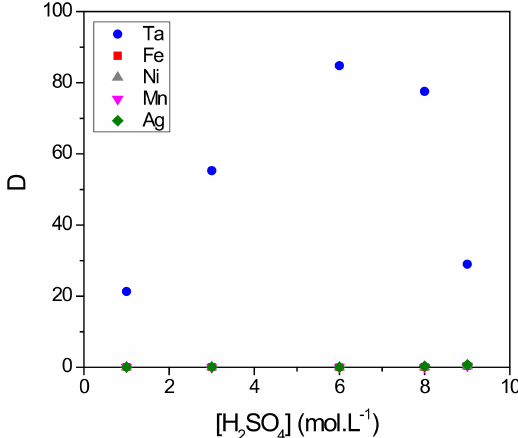
Figure 6. Effect of H 2 SO 4 concentration on the distribution coefficient D of Ta, Fe, Ni, Mn and Ag. Extraction conditions: A/O = 1; T = 22 ◦ C. Extraction time: 30 min. Organic phase (O): 4-MAcPh; Aqueous phase (A): [Ta] = [Fe] = [Ni] = [Mn] = [Ag] = 0.1 g · L − 1 , [H 2 SO 4 ] = 1–9 M, [HF] = 0.06